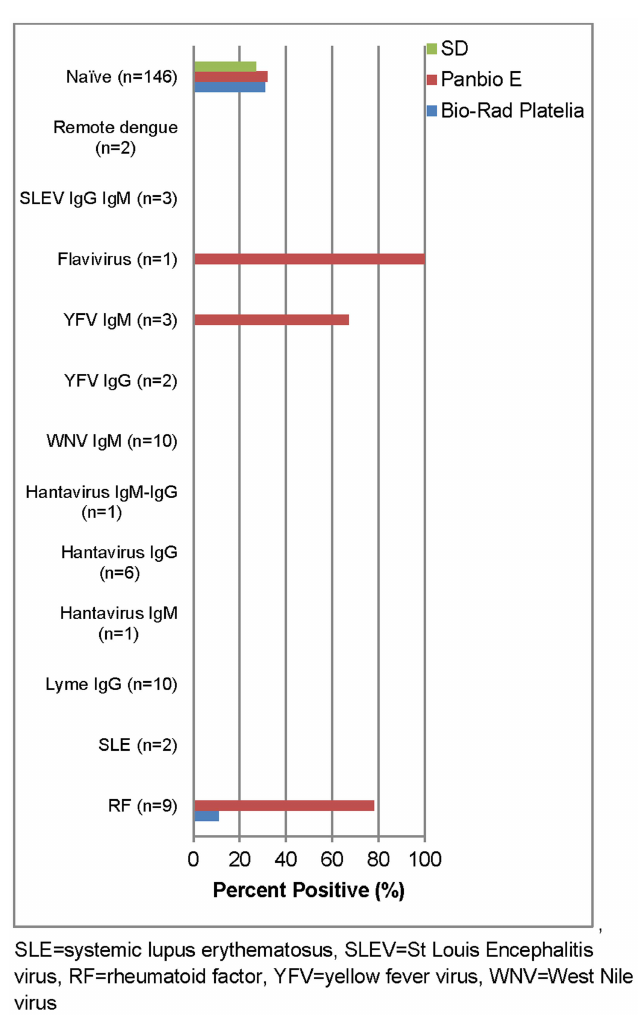
Figure 1. False positive rate of DENV NS1 ELISAs in DENV negatives and challenge panel specimens.